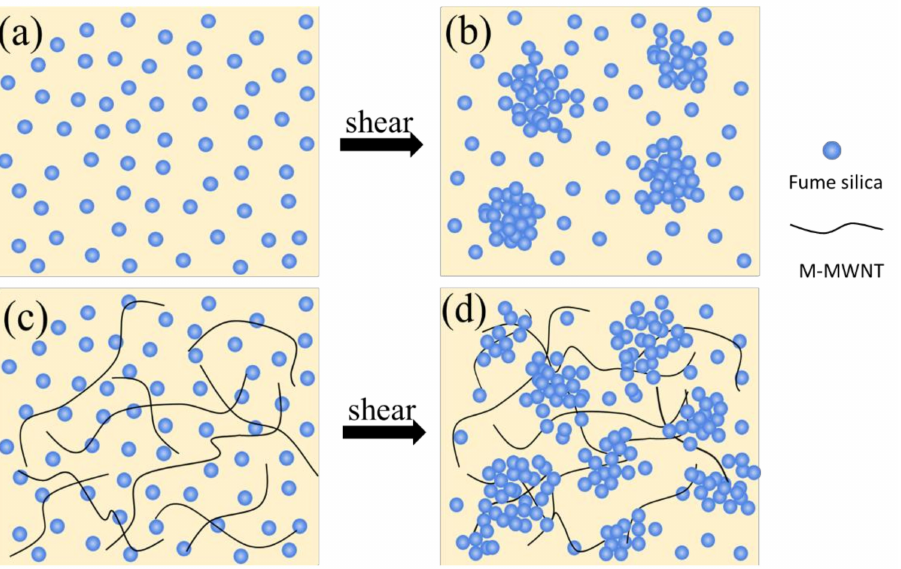
Figure 5. The mechanism of shear-thickening behavior of ( a ) original STF, ( b ) original STF under shear, ( c ) M-MWNT/STF, and ( d ) M-MWNT/STF under